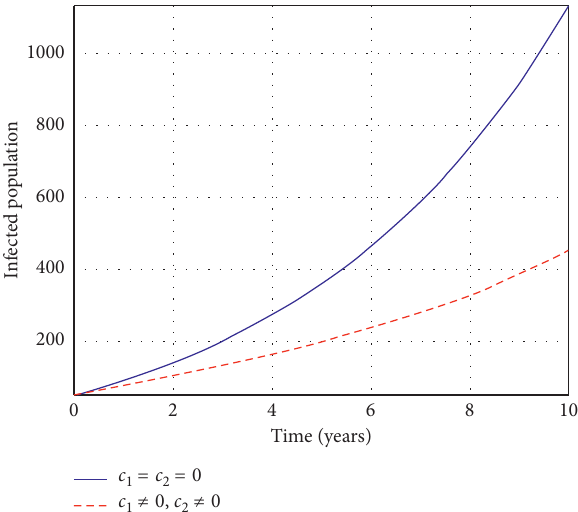
Figure 6: Control profile when c